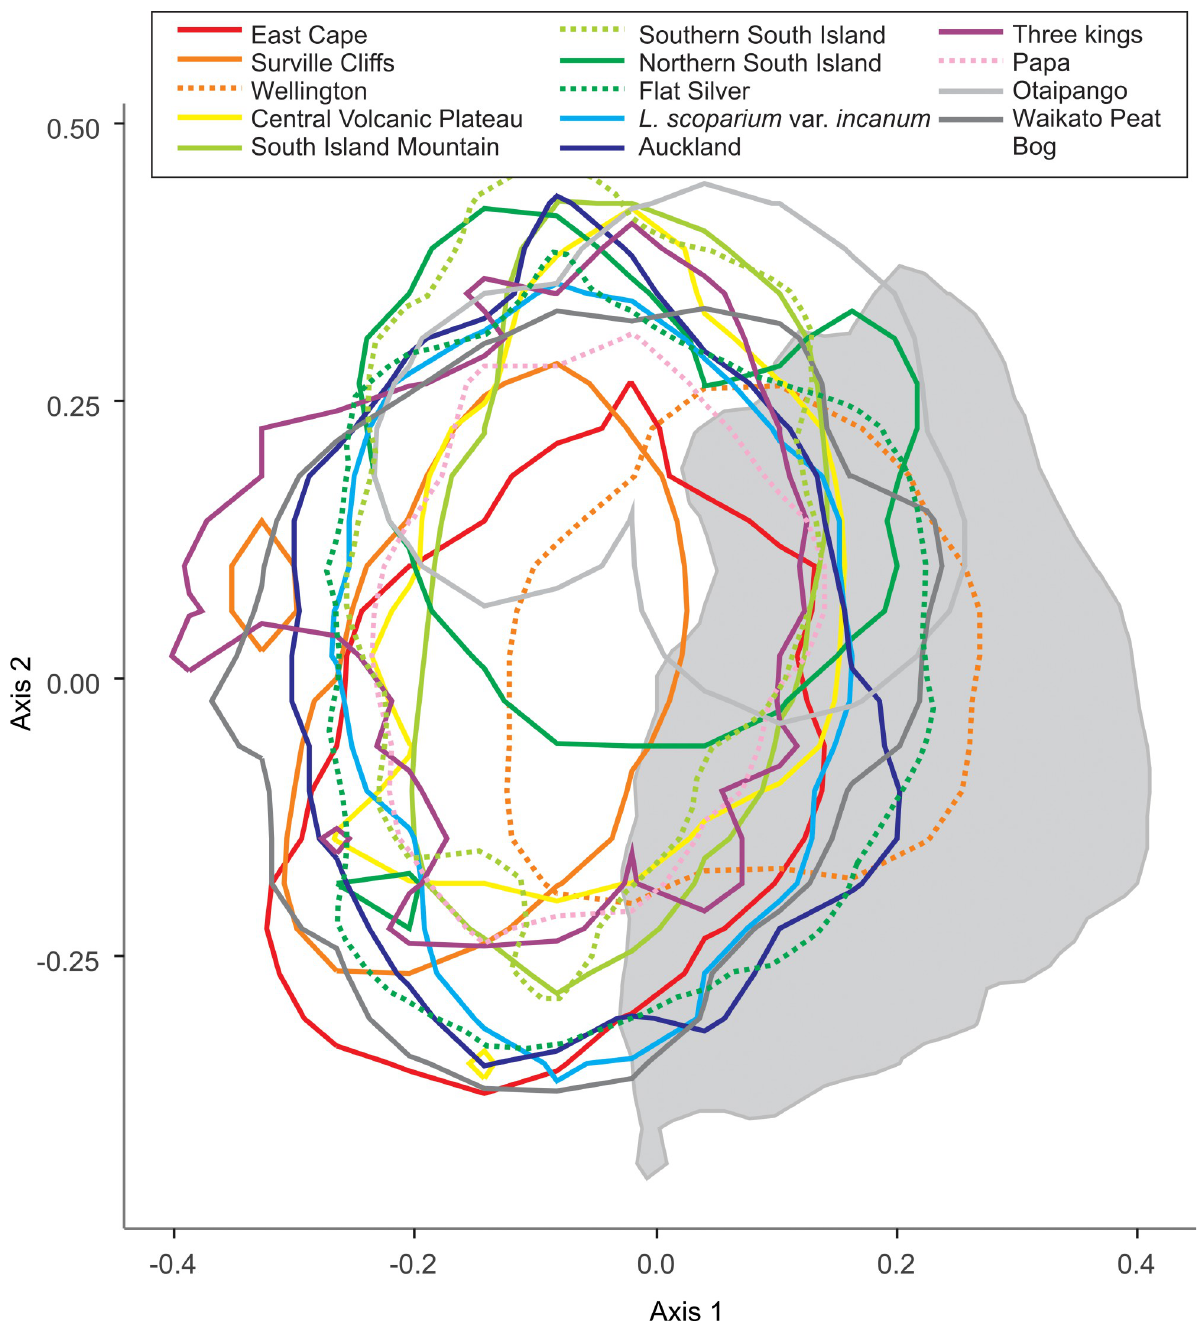
Fig 10. Principal component analysis of the seven core parameters for Leptospermum scoparium morphotypes pollen in polar view. Polygons show the 95% range highest posterior density region for each sub species. Underlying grey polygon is 95% range of Kunzea from Fig 9.